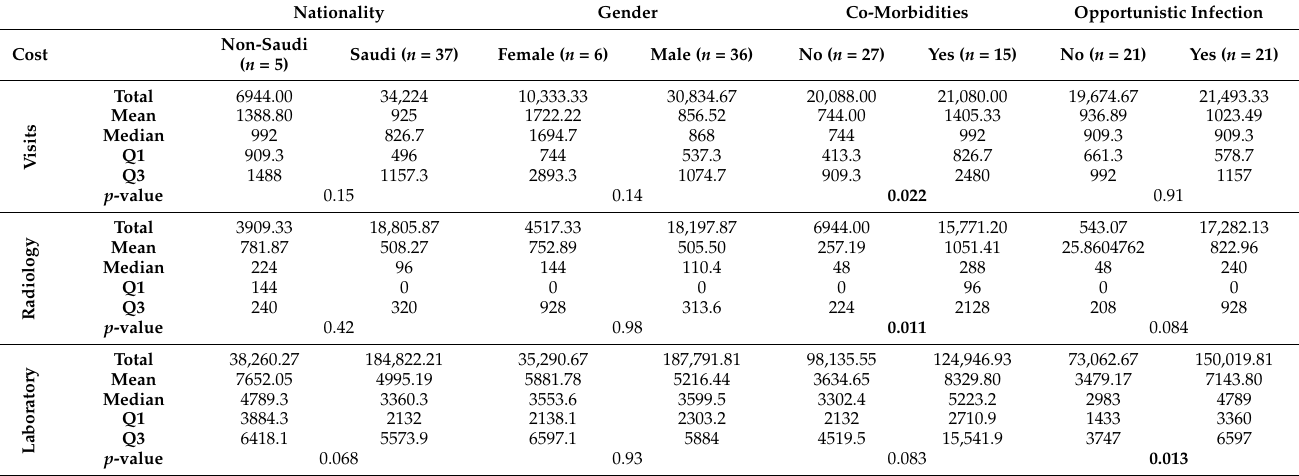
Table 4. Healthcare resources and medication costs (US$) according to PLHIV